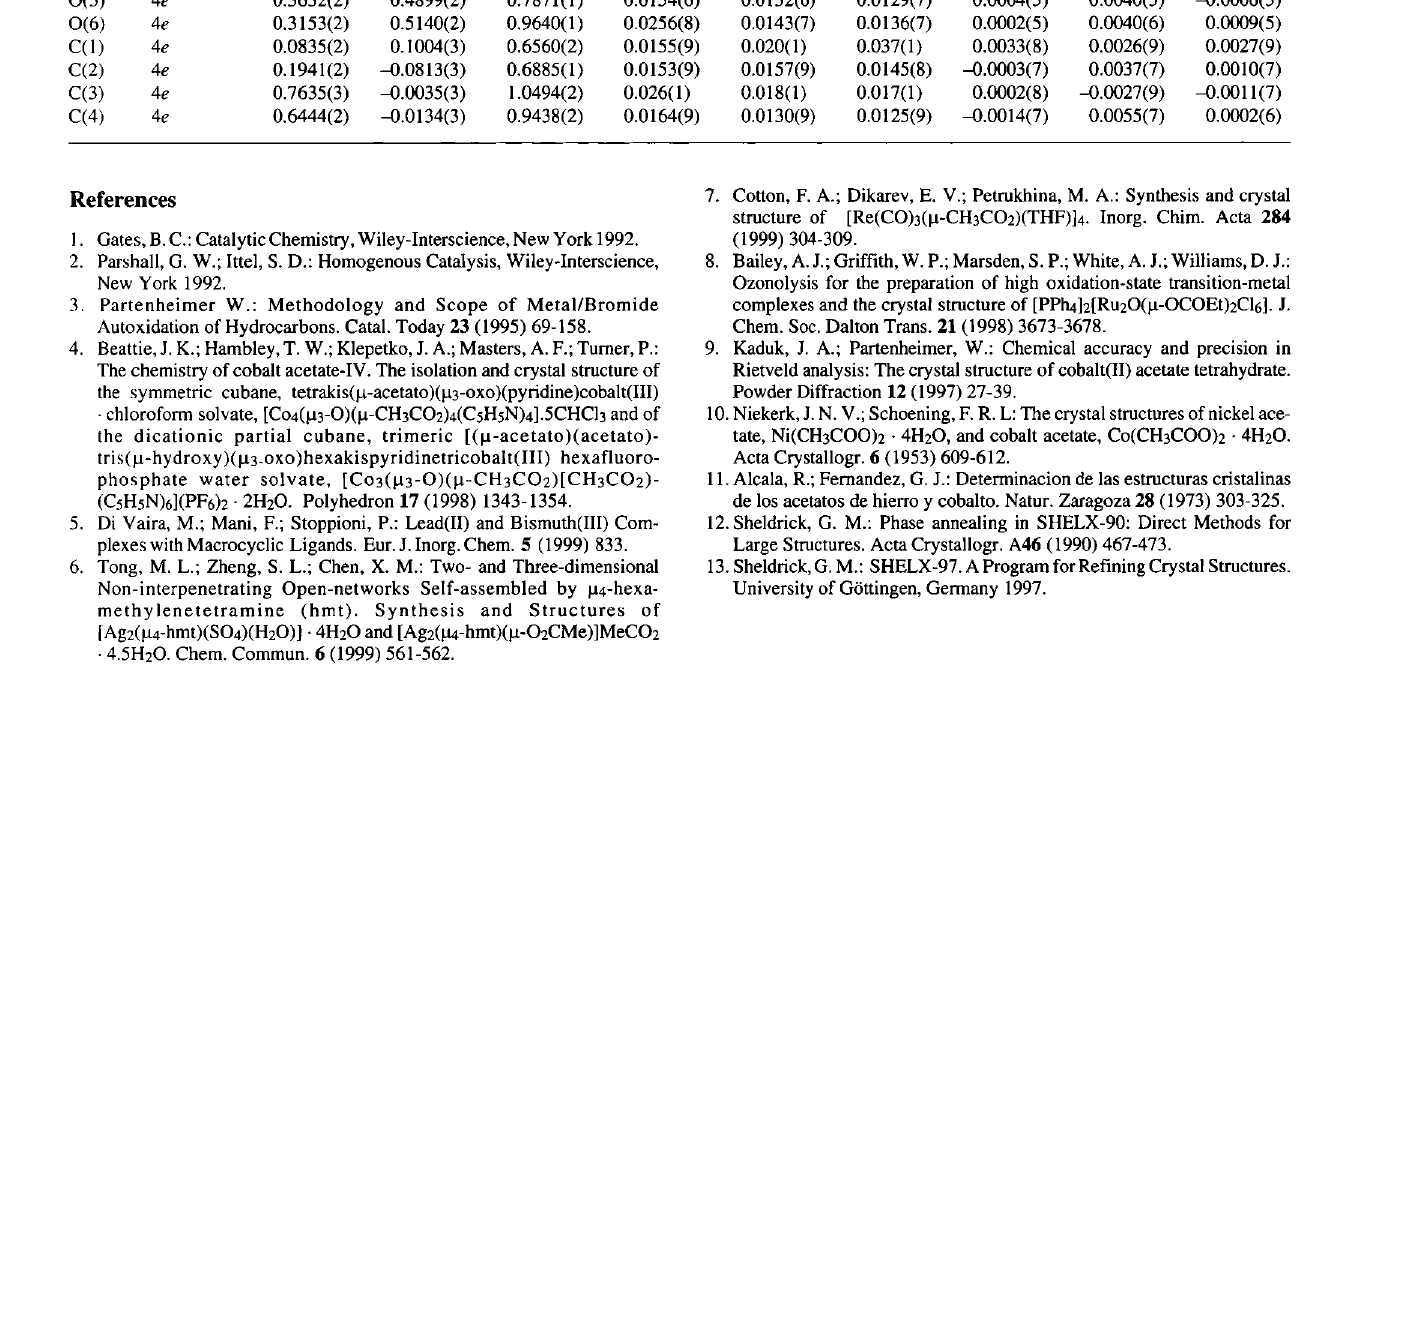
Table 3. Atomic coordinates and displacement parameters (in Ä 2